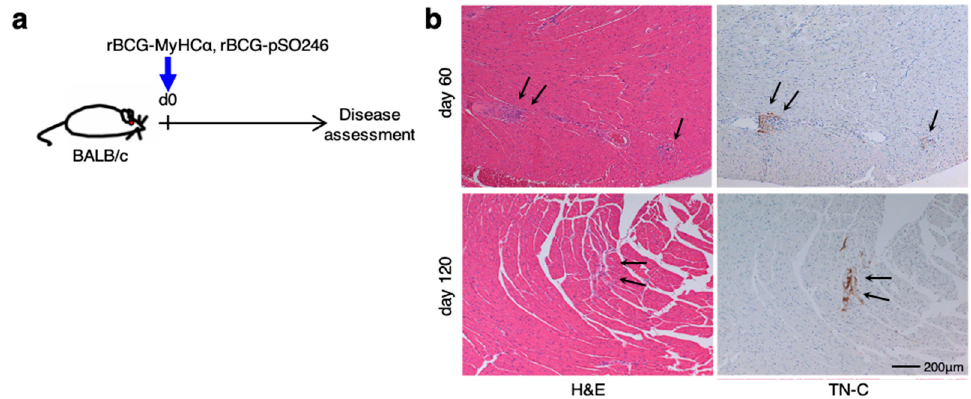
Figure 2. A single injection of rBCG-MyHC α induced chronic but weak myocarditis. ( a ) Mice were immunized with rBCG-MyHC α or rBCG-pSO246 on day 0. ( b ) Representative histology (H&E staining and TN-C immunostaining) of the heart sections on days 60 and 120 after rBCG immunization. Arrows indicate myocardial inflammation.